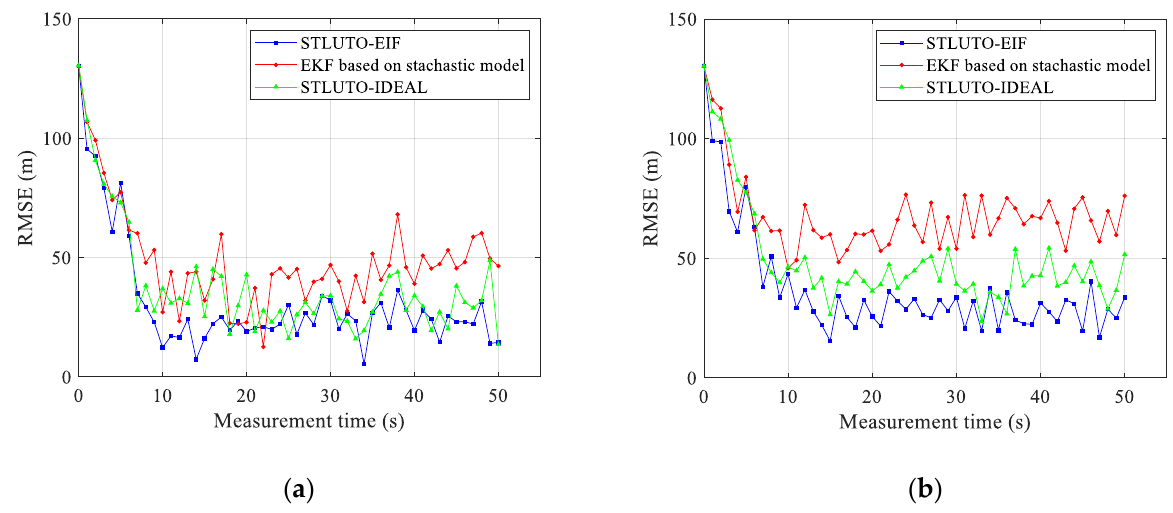
Figure 15. Localization performance for two scenarios. ( a ) RMSE for the scenario with zero minimum velocity constraint; ( b ) RMSE for the scenario with minimum velocity constraint as 5 m/s.